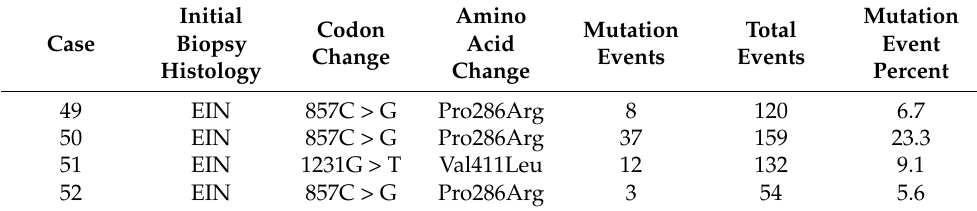
Table 2. Codon and amino acid changes in POLE -mutated